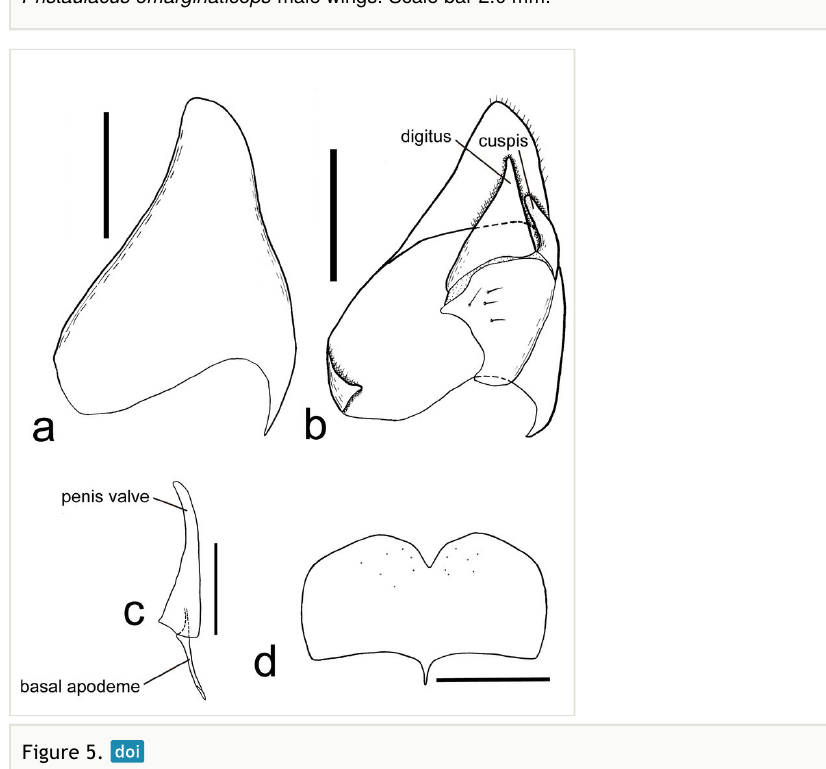
Figure 4. Pristaulacus emarginaticeps male wings. Scale bar 2.0 mm.